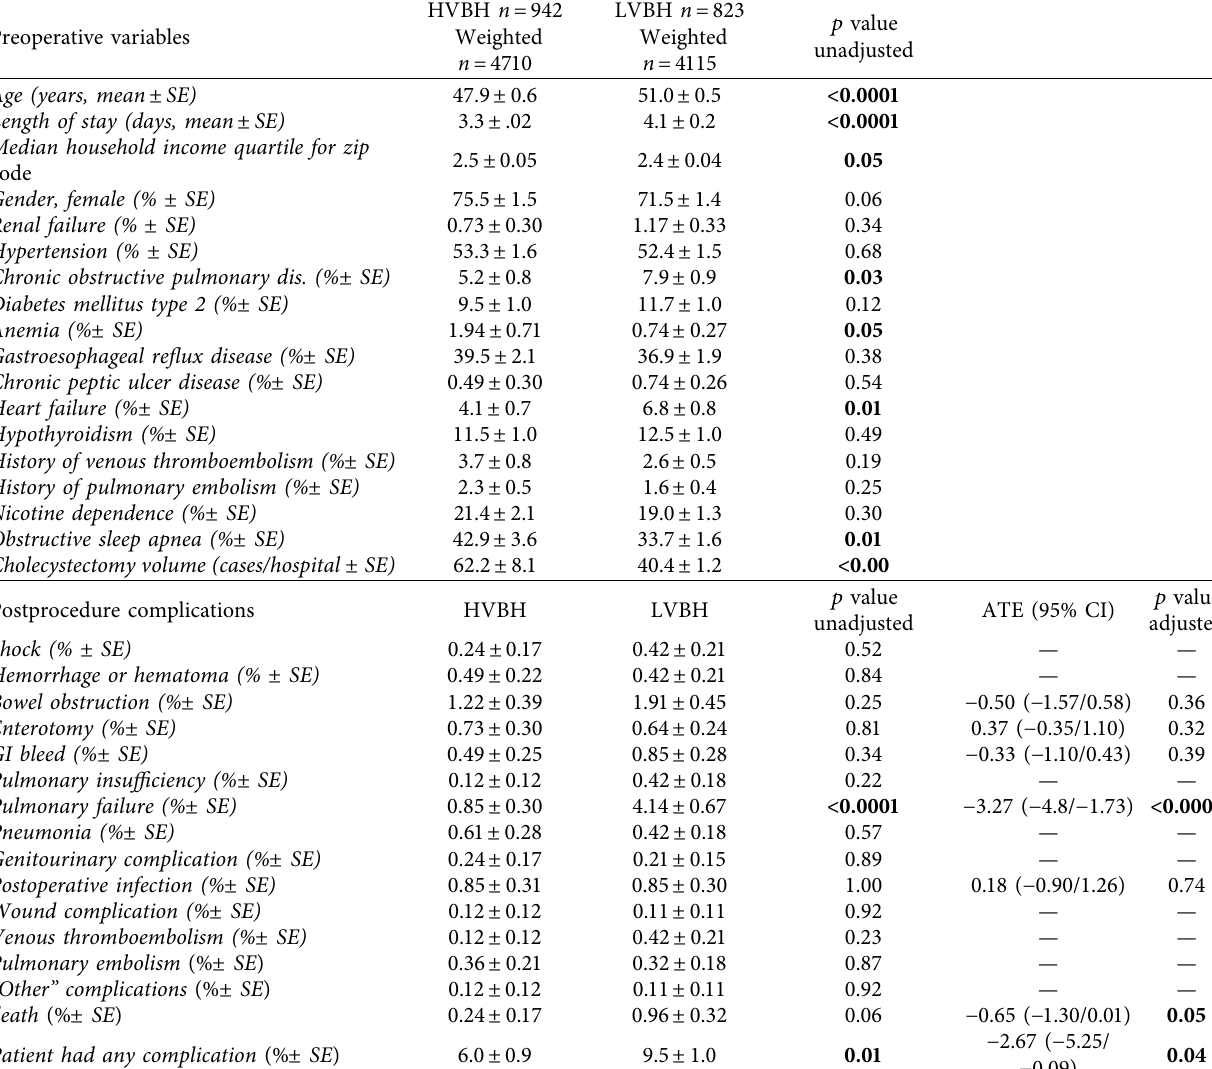
Table 2: Preoperative comorbidities and postoperative complications of patients with morbid obesity undergoing elective laparoscopic